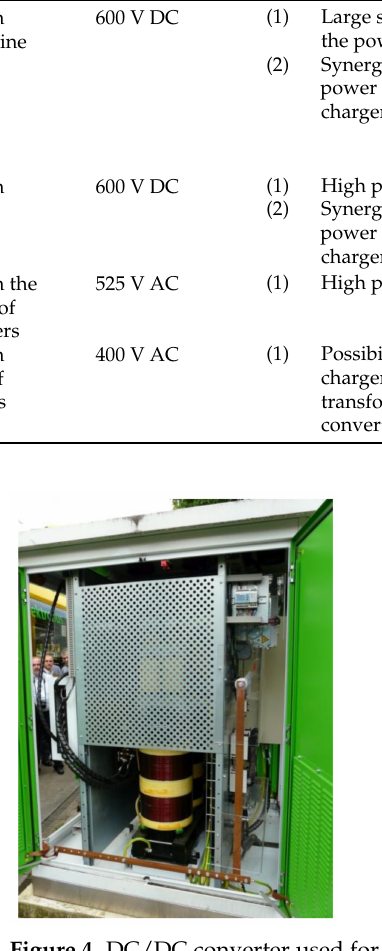
Figure 4. DC/DC converter used for powering a charging point for electric buses and cars from a tram overhead line in Oberhausen,